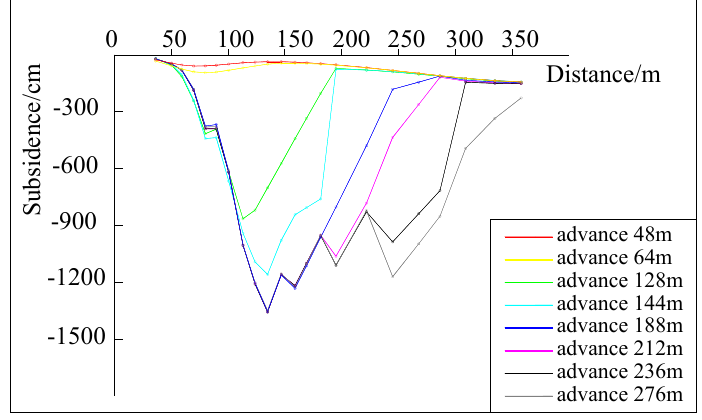
Figure 21. Subsidence curve.